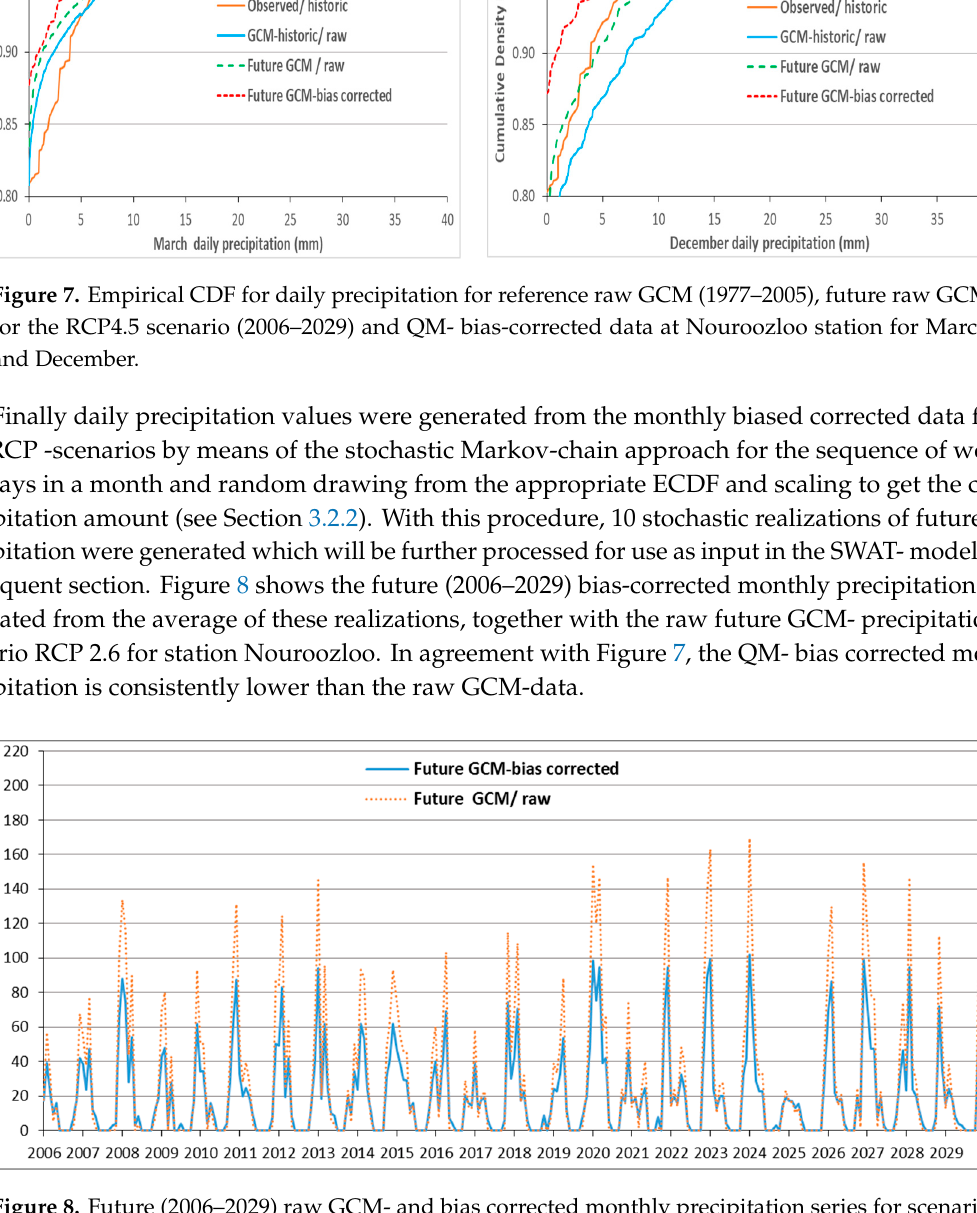
Figure 8. Future (2006–2029) raw GCM- and bias corrected monthly precipitation series for scenario RCP2.6 for Nouroozloo station.